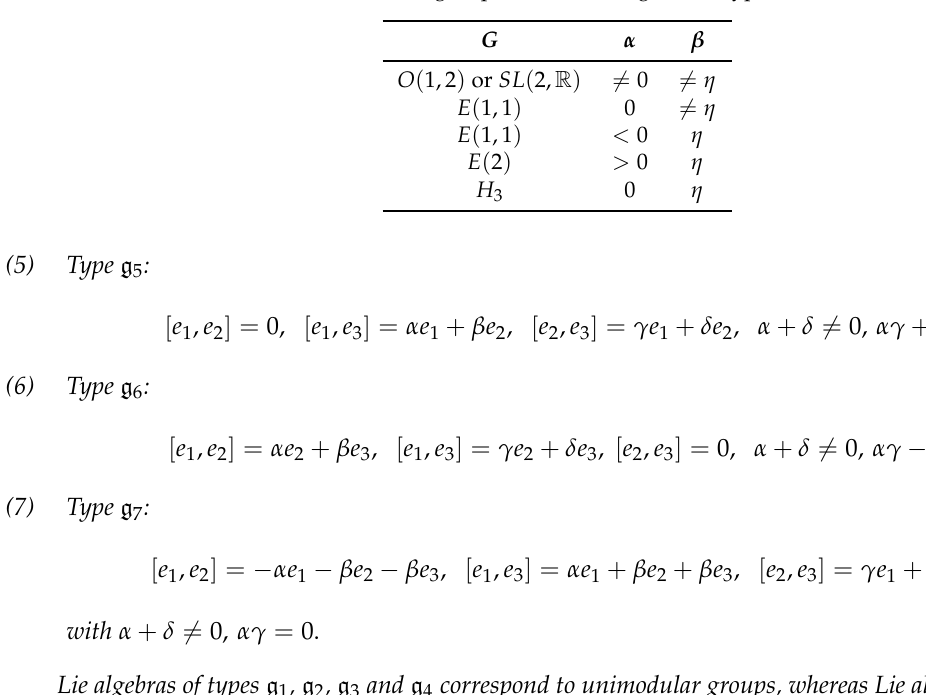
Table 3. Lie groups G with Lie algebra of type g 4